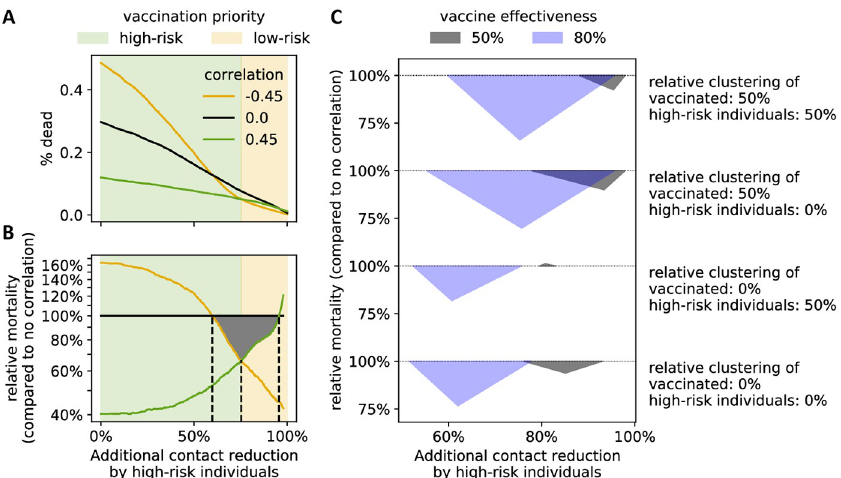
Fig 6. Level of contact reduction by high-risk individuals influences vaccination priorities. (A) The average mortality at a given additional contact reduction by high-risk individuals is shown for three different scenarios: negative ( − 0.45; yellow), zero (black) and positive (0.45; green) correlation between vaccinated and high-risk individuals. (B) Relative mortality compared to the case of no correlation (black line in A), at 50% homophily of both high-risk individuals and individuals who vaccinate. Black dashed lines and a gray triangle highlight the three intersection points of the three curves. (A-B) homophily of those who vaccinate and of high-risk individuals: 50%, vaccine effectiveness: 80%. Background colors indicate the prioritization (high-risk or low-risk individuals) that leads to lower overall mortality. (C) The location of the intersection points from (B) is shown for all combinations of homophily of those who vaccinate (0% vs 50%) and of high-risk individuals (0% and 50%), as well as two levels of vaccine effectiveness: 50% (gray) and 80% (blue). S4 Fig contains the full curves for all eight considered combinations.